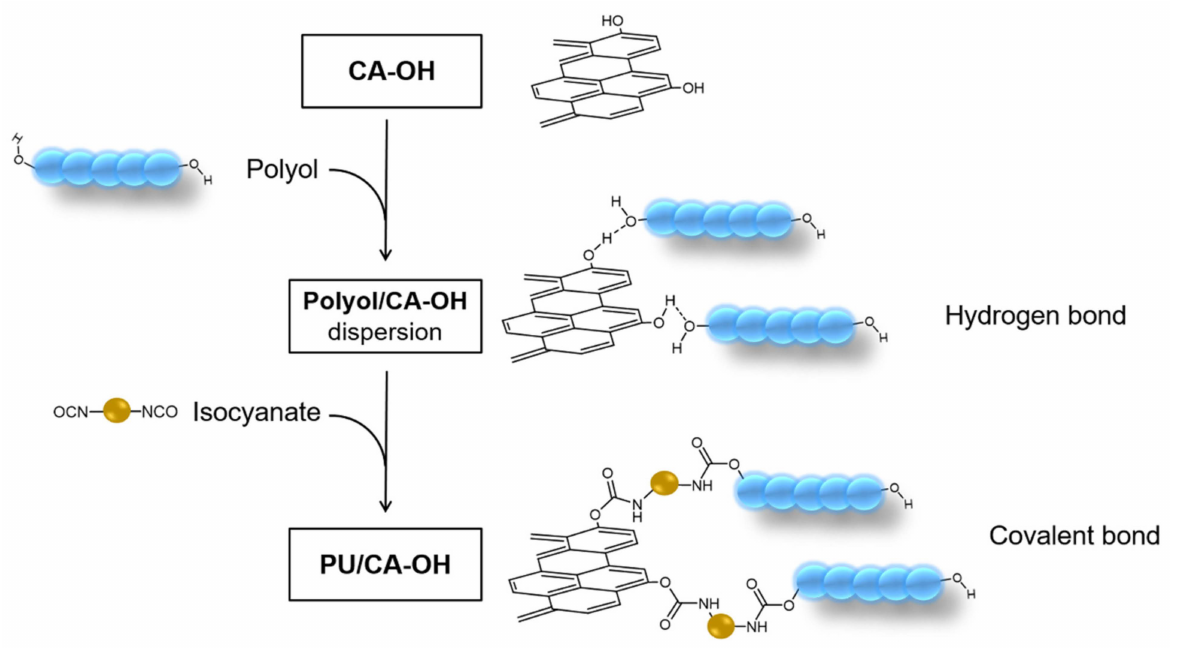
Figure 1. Scheme for the in situ preparation of polyurethane in the presence of sp 2 carbon